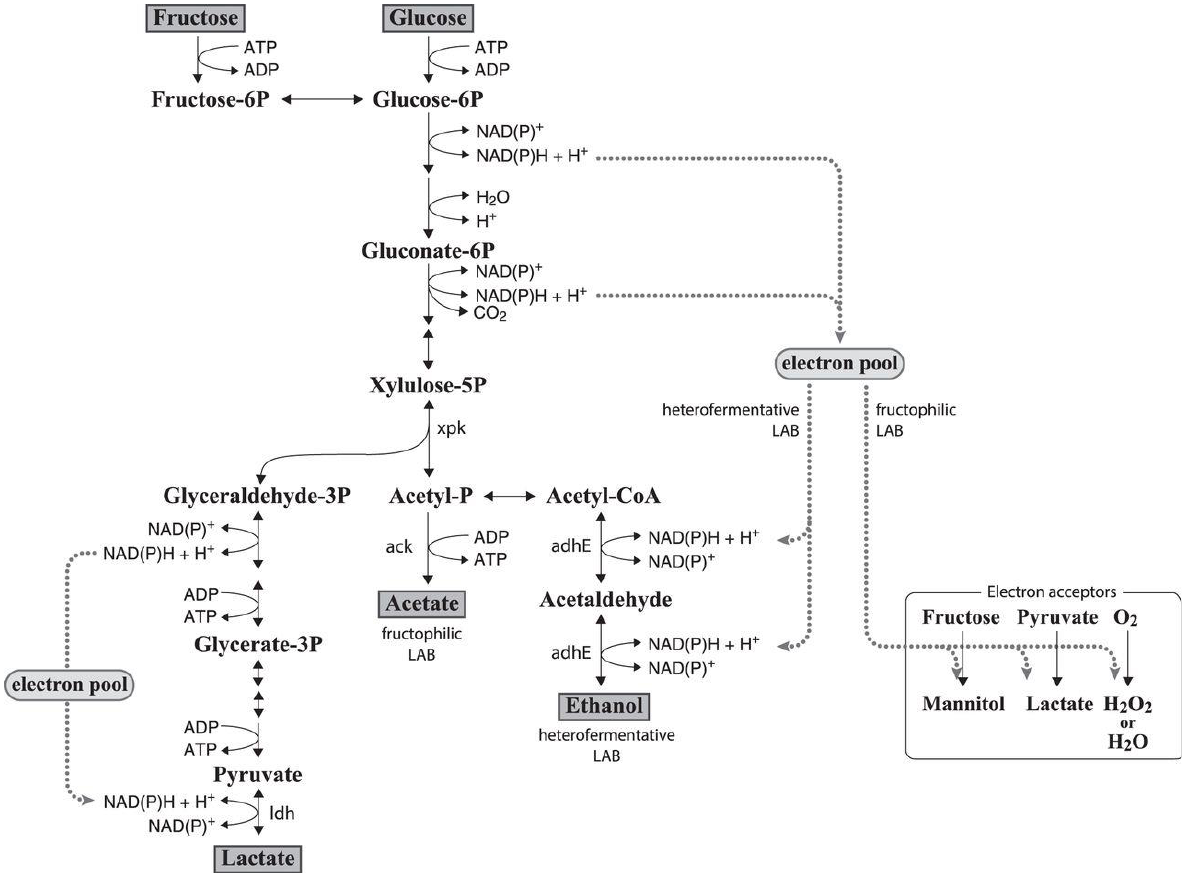
Figure 3. Utilization of glucose by fructophilic LAB. Adapted with permission from Endo et al. [140]).